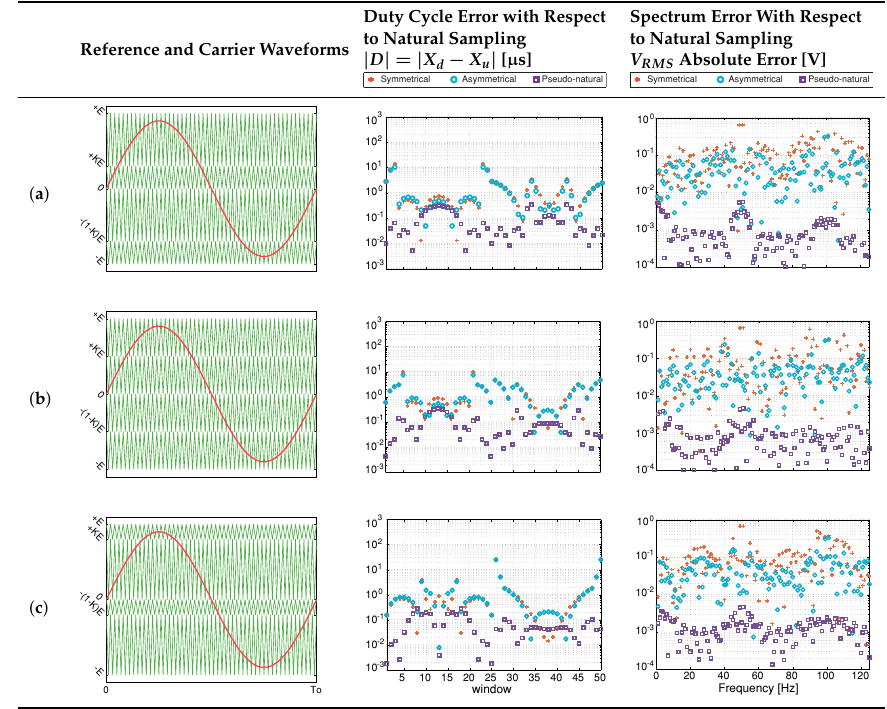
Table 3. Comparison of sampling methods in the time and frequency domains: Regular symmetrical, regular asymmetrical, and pseudo-natural against natural sampling with PD-SPWM, E = 50 V, M f = 50, M a = 0.9, and r 1 = r 2 = r 3 = r 4 = 0.5 for ( a ) K = 0.3, ( b ) K = 0.5, and ( c ) K = 0.8.